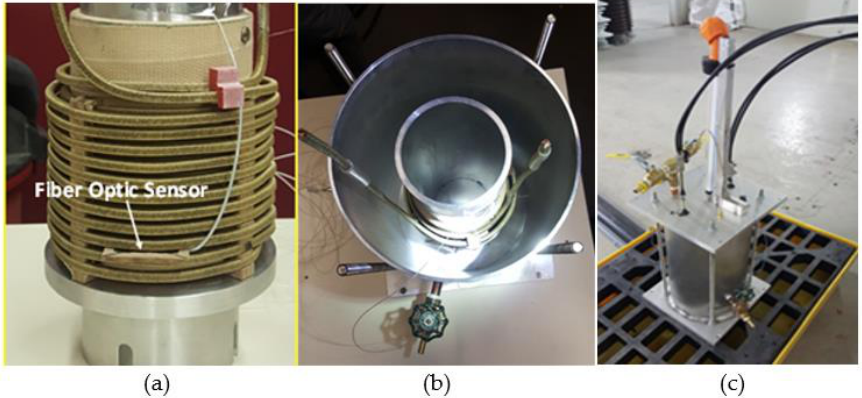
Figure 7. Laboratory transformer: ( a ) overview of the core, pressed paper, and winding assembly; ( b ) overview of the tank containing the core winding assembly; ( c ) overview of the laboratory trans- former with external connections.